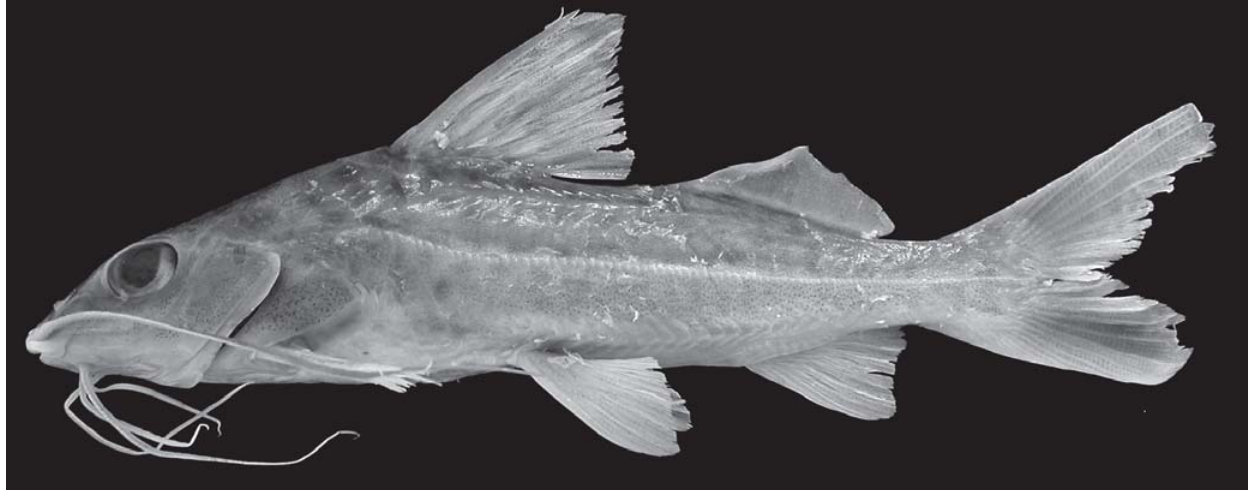
Fig. 2. Pimelodus pohli , new species. Paratype, rio Empoeirado, rio São Francisco drainage, Minas Gerais, Brazil (MCP 16668, 85.3 mm